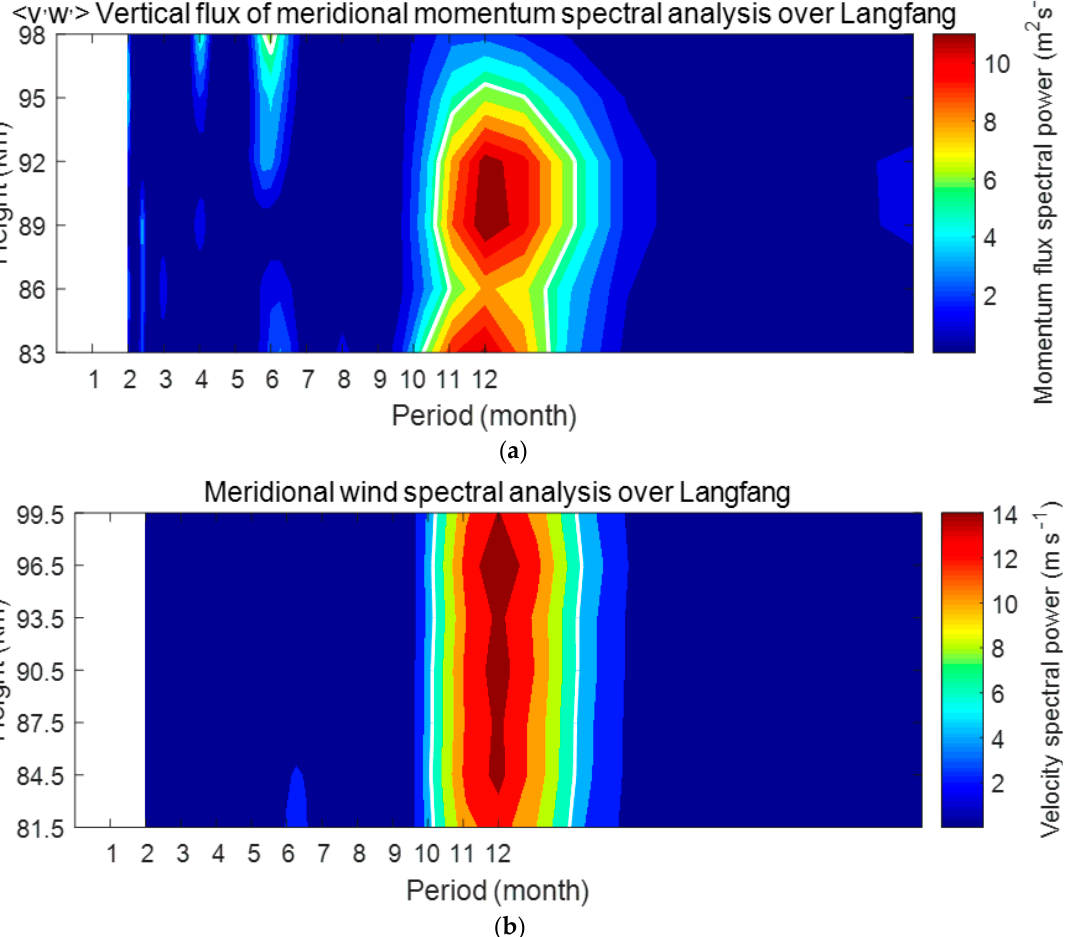
Figure 4. Height-time cross-sections of Lomb-Scargle spectral analysis results for monthly averaged meridional momentum flux and mean meridional background wind (similar to the data shown in Figure 2). ( a ) Vertical flux of meridional momentum spectral analysis over LangFang; ( b ) Meridional wind spectral analysis over LangFang